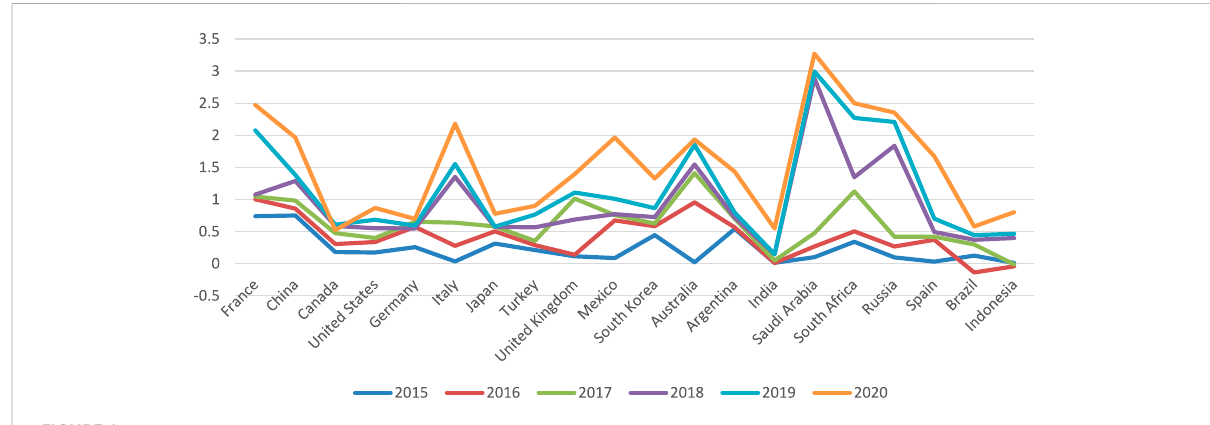
FIGURE 1 Input-output based empirical movement of energy prices risk.